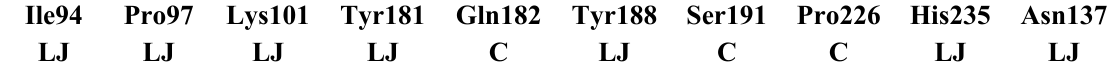
Table 7. Cross-correlation matrix among the Eq.E